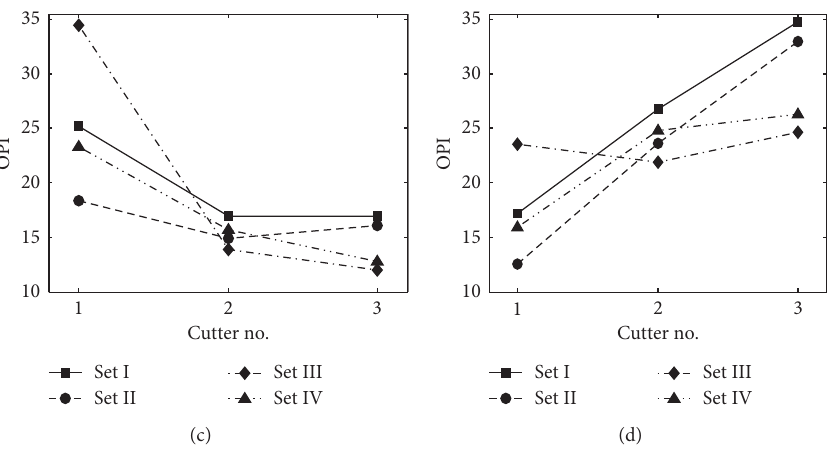
Figure 5: OPIs of the three cutters under different sets of weighting factors of geological conditions. (a) Set 1. (b) Set 2. (c) Set 3. (d) Set